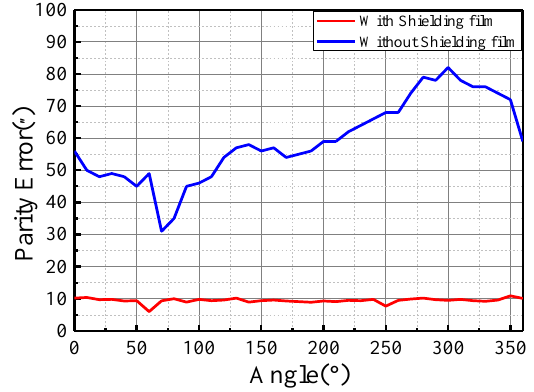
Figure 15. Parity error of inductosyn.